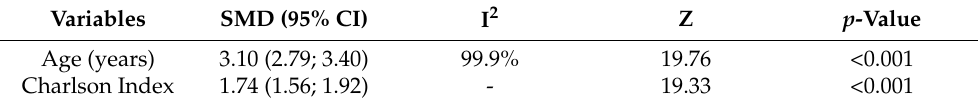
Table 3. Meta-analysis of factors (quantitative variables) associated with